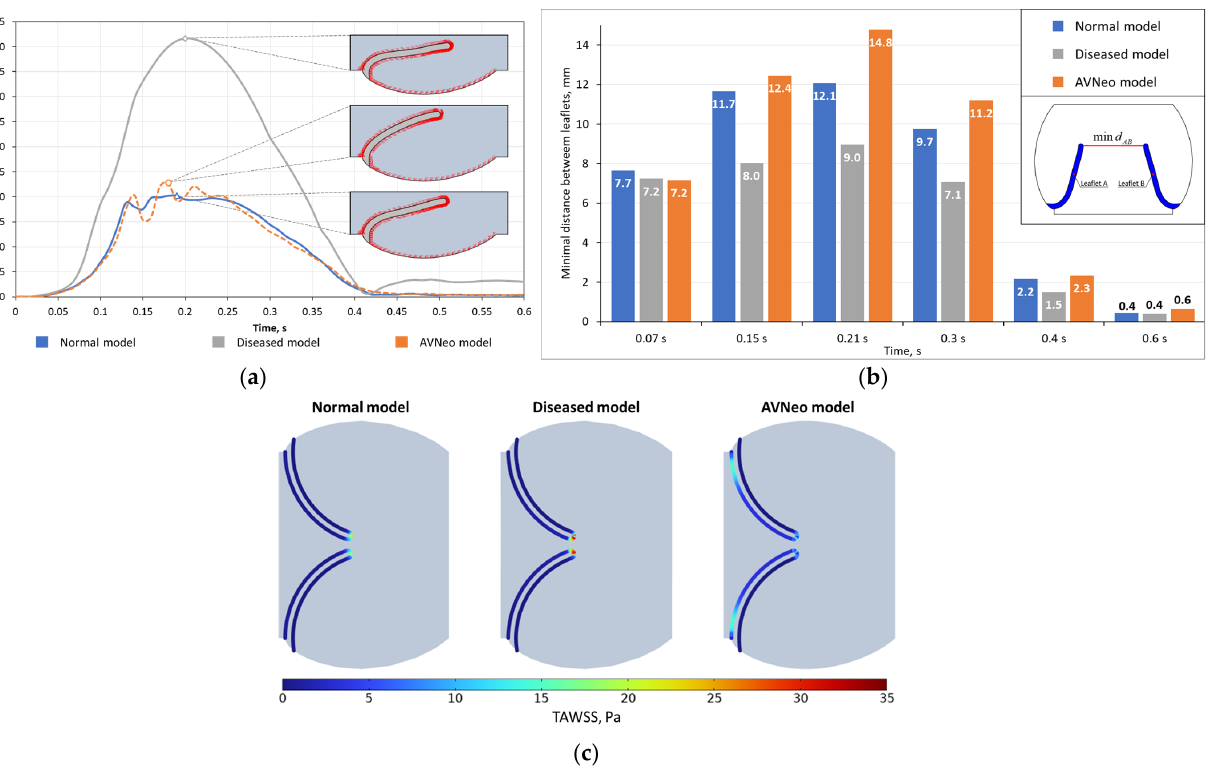
Figure 8. ( a ) Maximum wall shear stress with shear vectors along the boundary; ( b ) minimal distance between leaflets; ( c ) time-averaged wall shear stress (TAWSS).